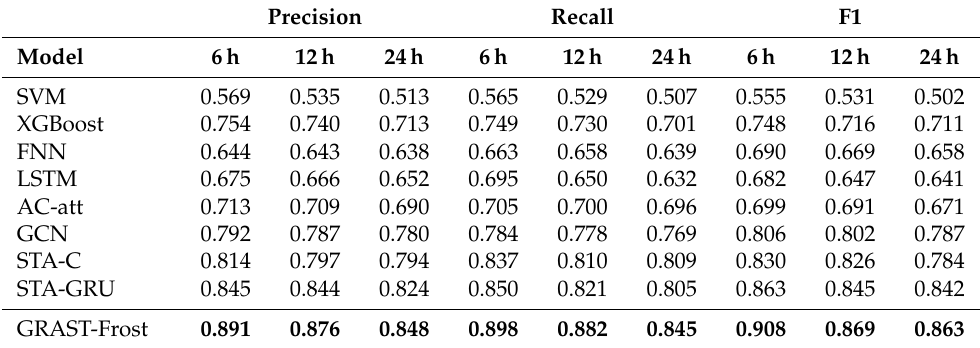
Figure 10. Receiver operating characteristic (ROC) curve comparing GRAST-Frost with other mod- els implementations. Table 2. Average precision, recall and F1 metrics for classification of frost events according different models implementations. Best values are highlighted in